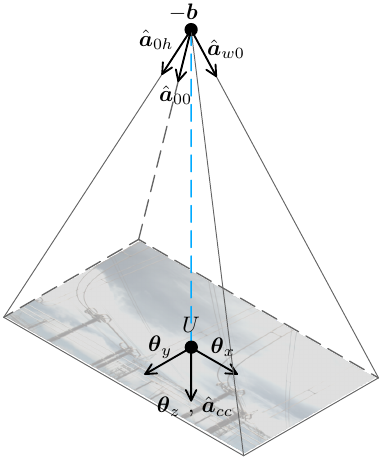
Figure 4. Determining the pose of the rectangular region v 2